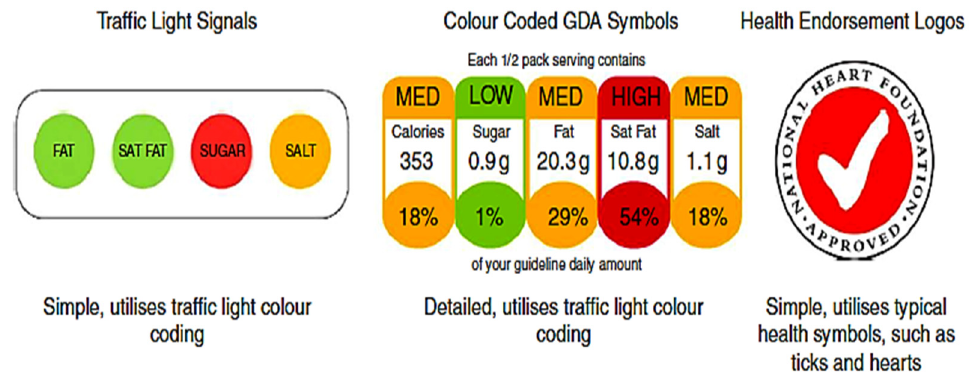
Figure 1. Popular nutrition labeling formats. Source : Montandon and Colli, [31].